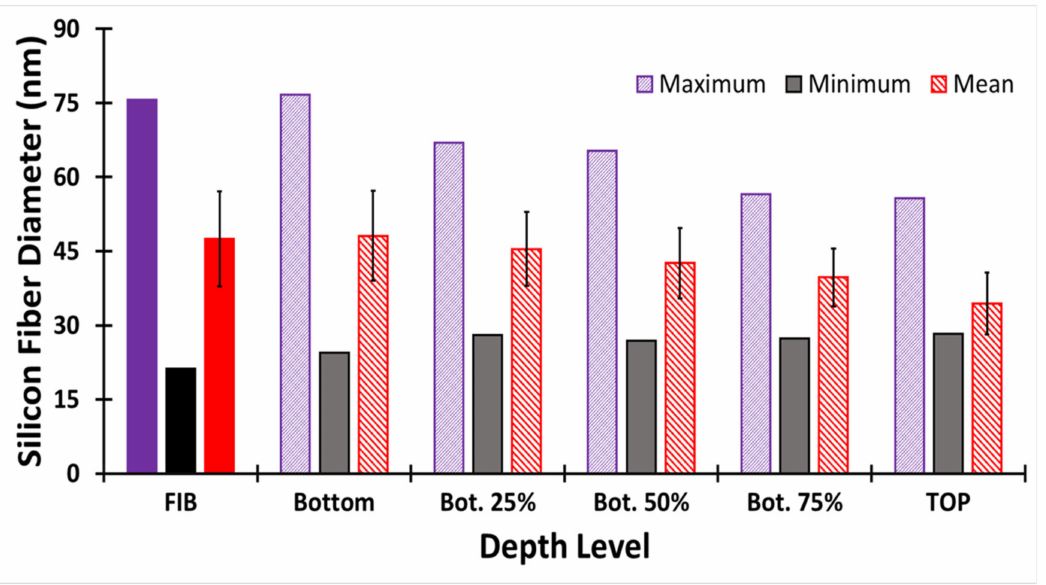
Figure 7. Graph for FIB/SEM comparison. FIB etched regions, which are illustrated in solid fillings on the left-most side, were measured at least 100 times for different fibers. Data shown here is from the experiment set 1